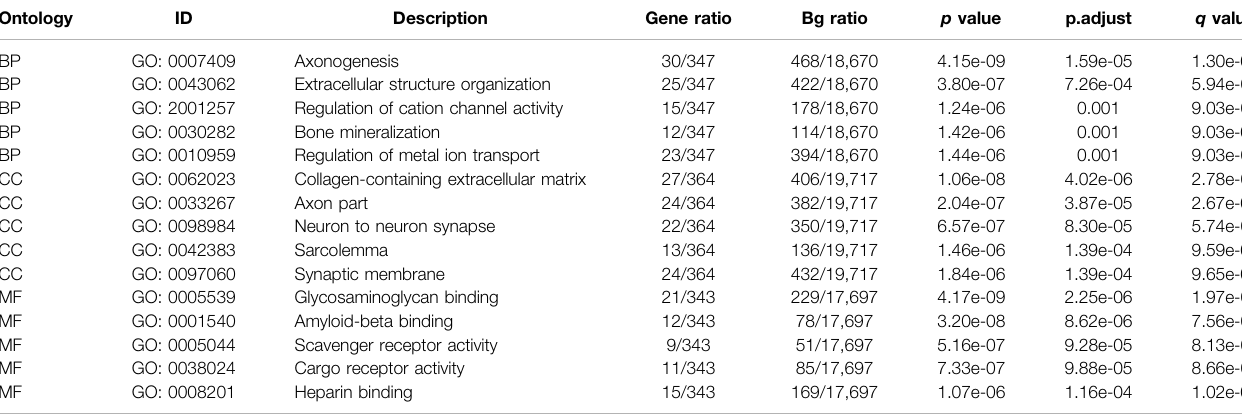
TABLE 4 | GO enrichment analysis of positively correlated